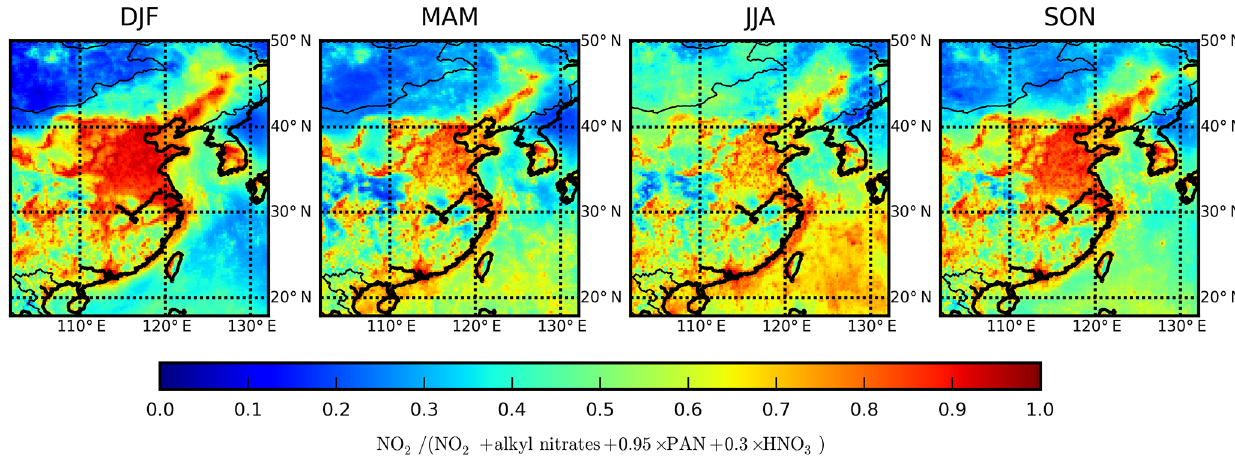
Figure 5. Seasonally averaged correction factors for interference in NO 2 measurements using chemiluminescence analyzers as estimated from a CHIMERE simulation driven by the DECSO emission inventory for the year 2015. Table 2. Correlation coefficient, regression slope, root-mean-square error (RMSE), and normalized mean error (NME) in 2015 of the sim- ulated surface NO 2 concentrations driven by DECSO 2015, MIX Asian 2010, and the corrected DECSO emission inventory versus the corrected in situ measurements. The intercept is set to 0 when performing the regression. The unit of RMSE is µgm − 3 . Category